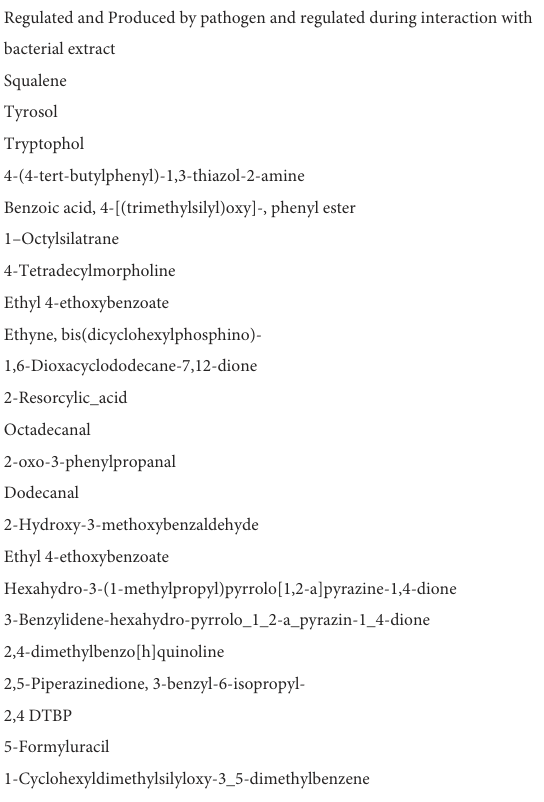
TABLE 2 Metabolites regulated during active growth of pathogen. Regulated and Produced by pathogen and regulated during interaction with bacterial